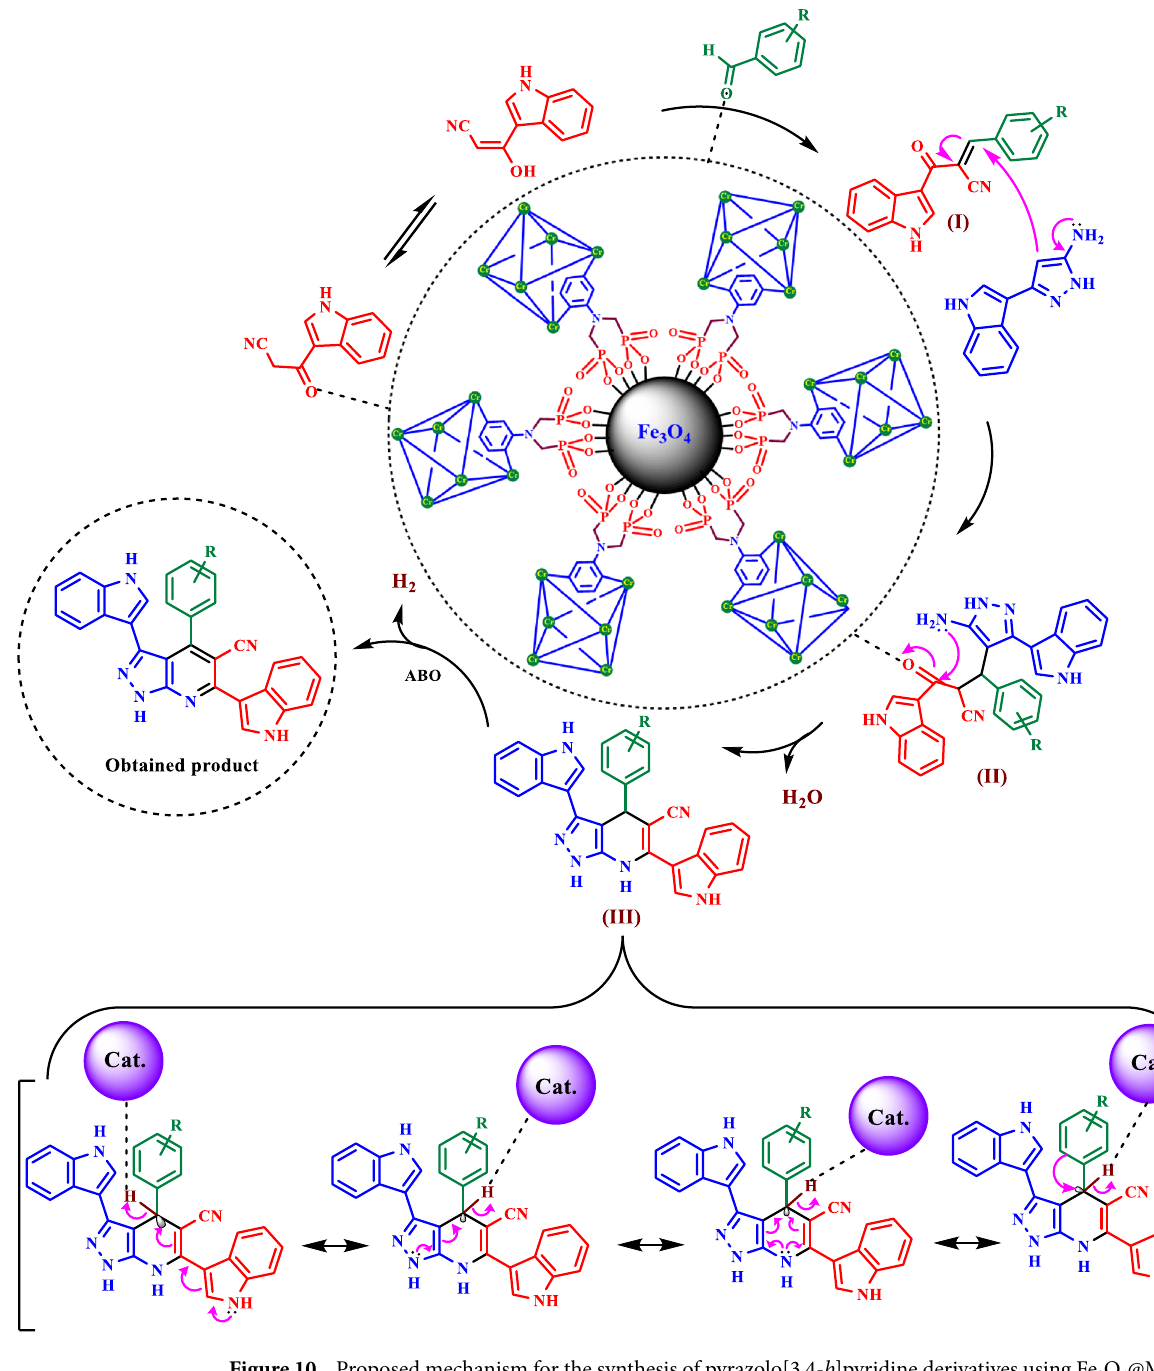
Figure 10. Proposed mechanism for the synthesis of pyrazolo[3,4- b ]pyridine derivatives using Fe 3 O 4 @MIL- 101(Cr)-N(CH 2 PO 3 ) 2 as